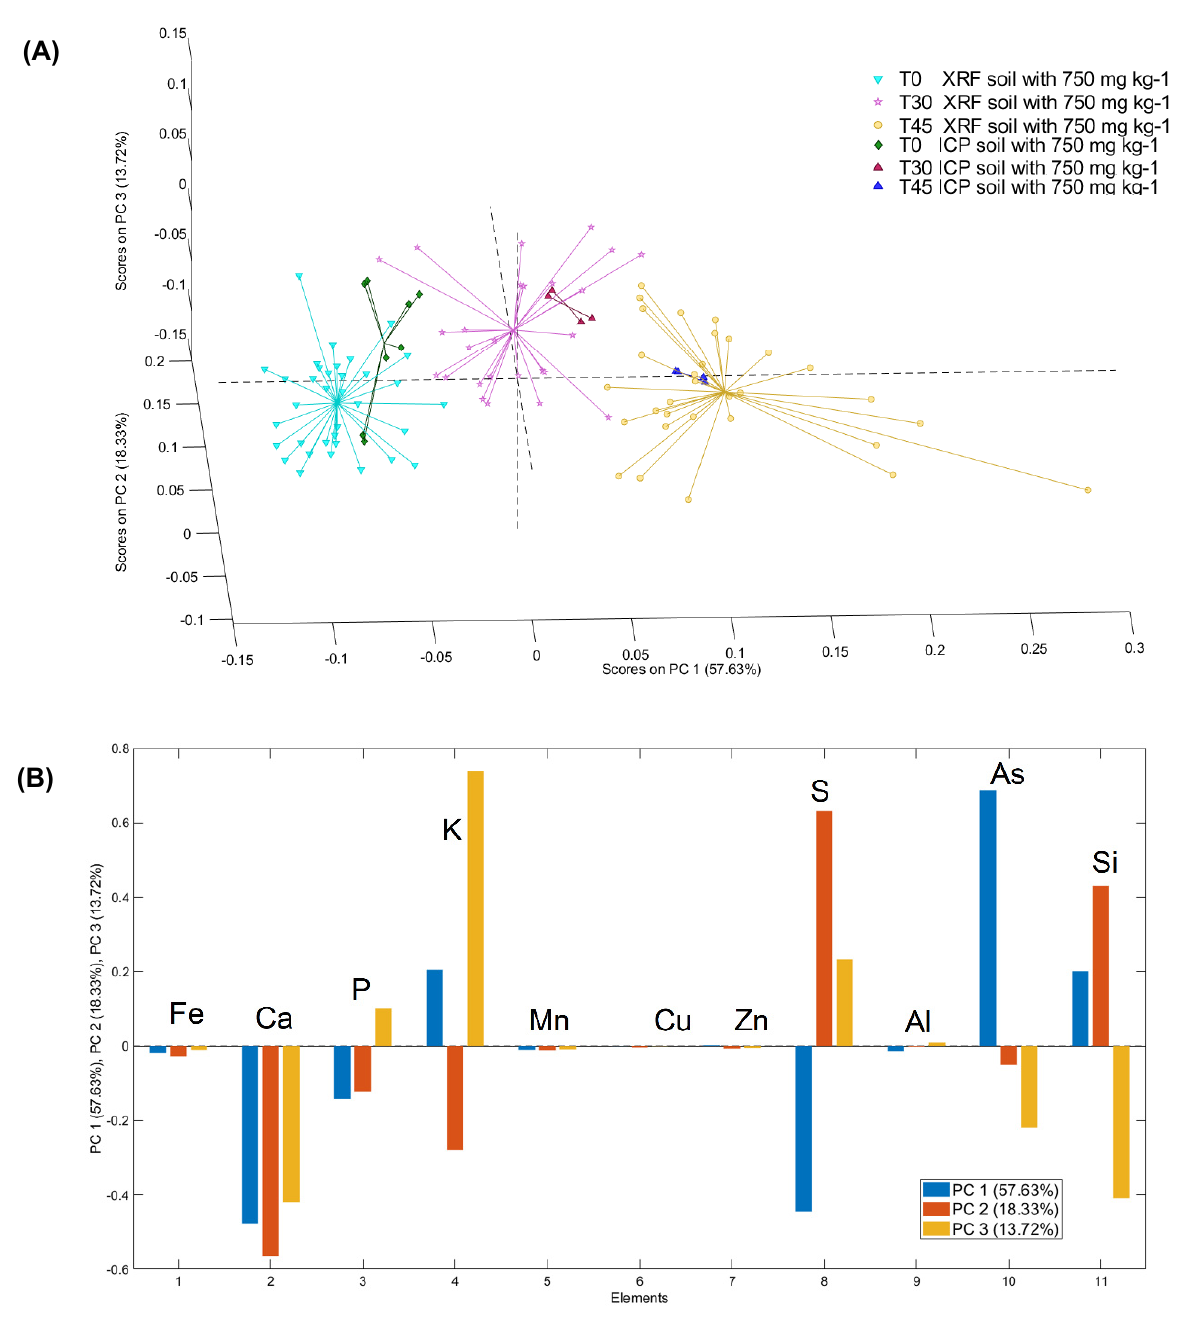
Figure 7. 3D PCA ( A ) score and ( B ) loading (PC1, PC2, PC3) plots of the µXRF and ICP–OES data for T0, T30 and T45 for plants grown on soil